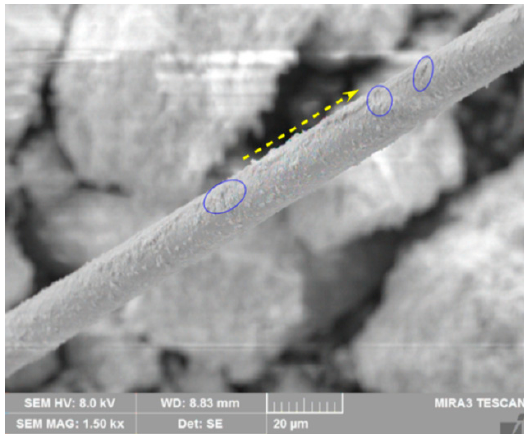
Figure 18. Grooves and scratches formed on the fiber surface.